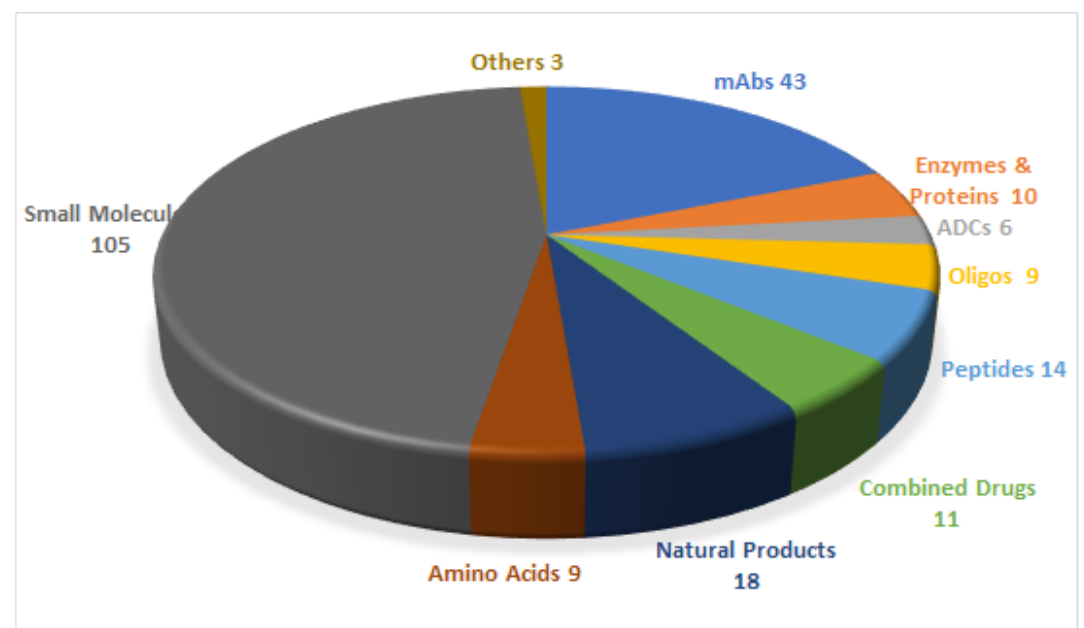
Figure 1. A total of 228 new drugs were approved by the Food and Drug Administration (FDA) from 2016 to 2020 [2]. mAbs, monoclonal antibodies; ADCs, antibody drug conjugates; Oligos, oligonucleotides. Table 1. Summary of the 2020 FDA peptides and oligonucleotides (TIDES)